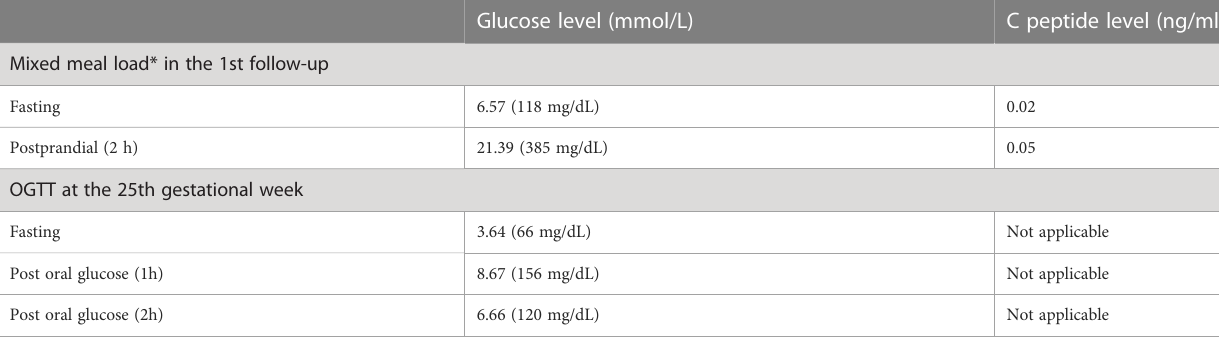
TABLE 1 Results of mixed meal tolerance test in the 1st follow-up and OGTT at the 25th gestational week.